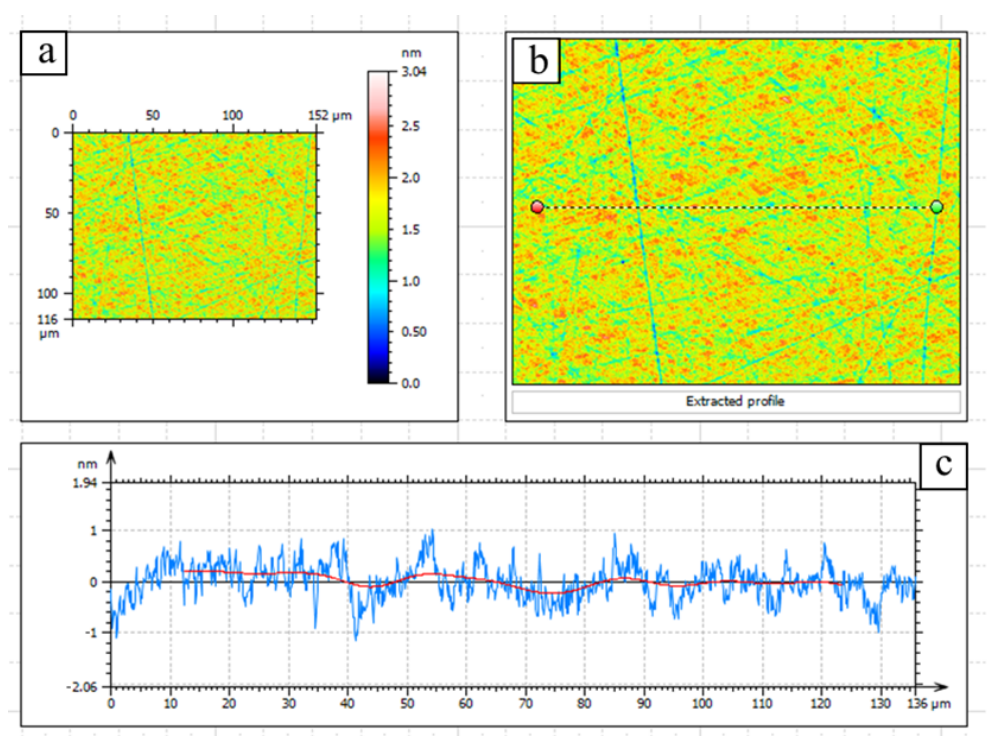
Figure 2. Surface topography and roughness profile of sample No. 2, before MRP . ( a ) . Surface topography of sample, ( b ) Surface topography of sample with a dashed line, ( с ) roughness profile of the sample along the dashed line.